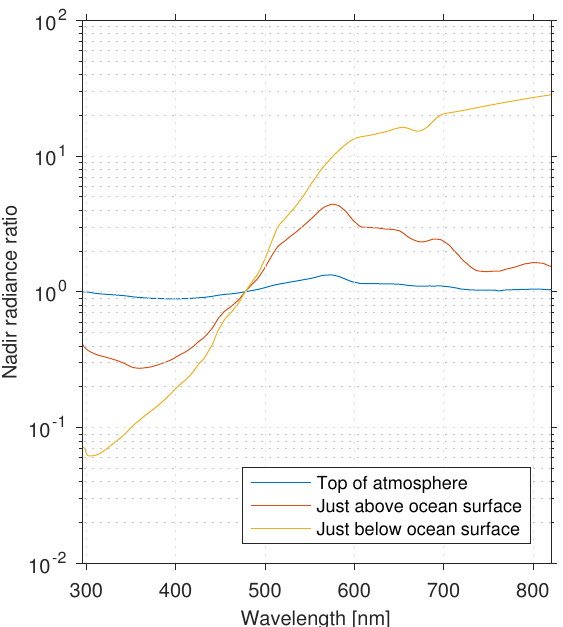
Figure 6. The ratio of the values for turbid water to those for clear water in Figure